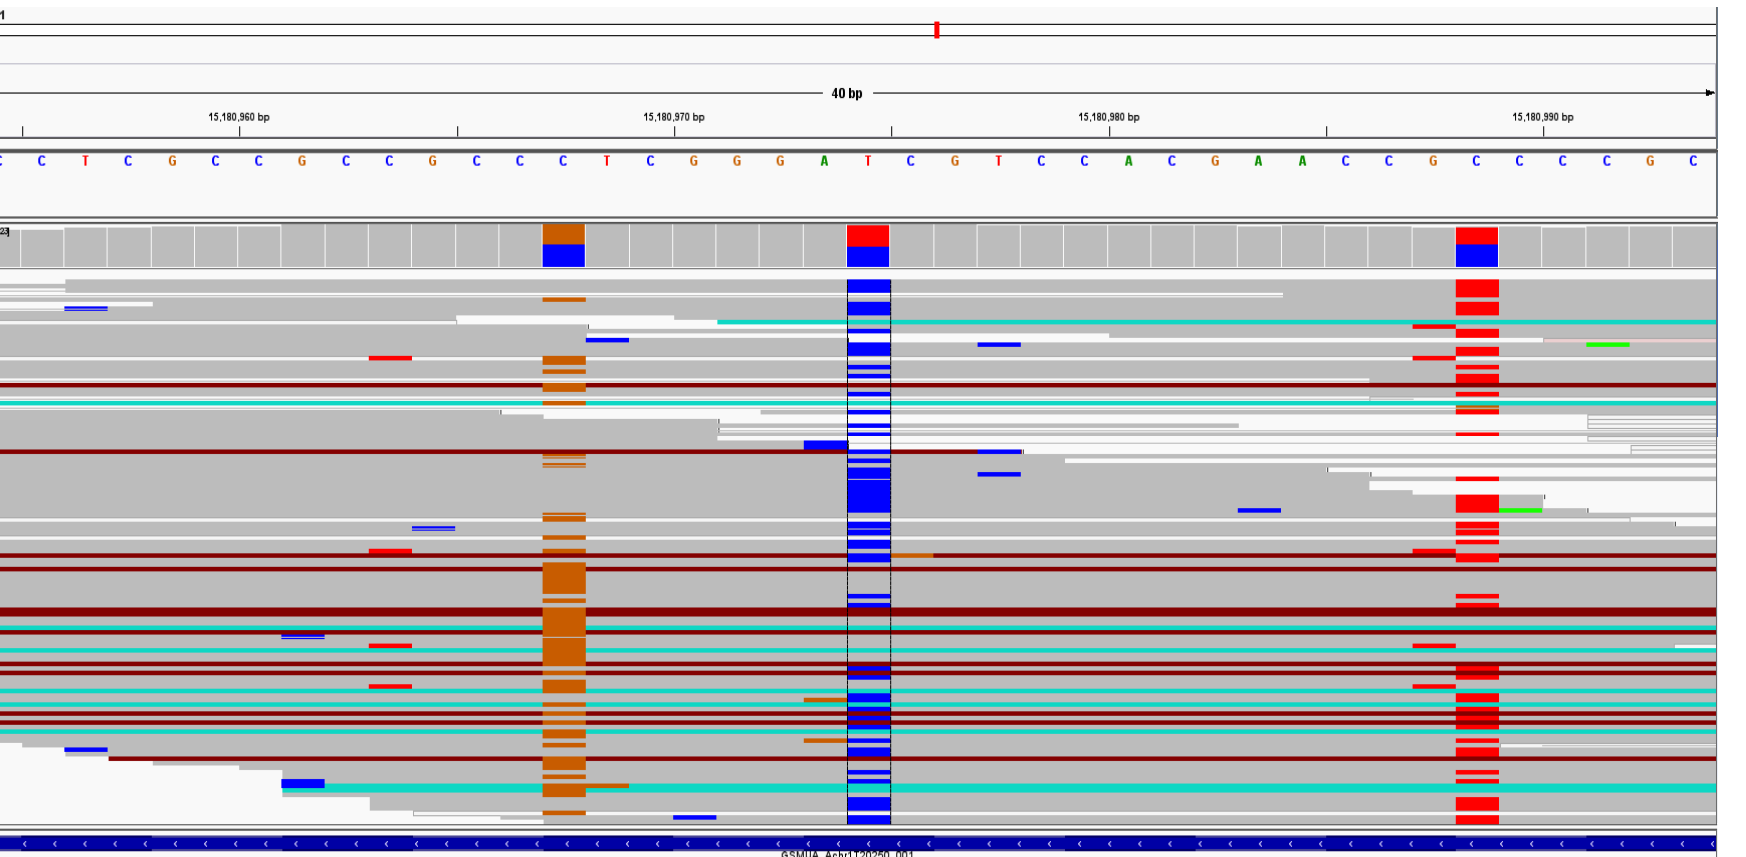
Figure 3. Example of a protein-coding gene that is heterozygous in enset. We aligned enset genomic sequence reads against the banana genome using BWA. The figure shows a 40-nucleotide region of the alignment falling within a protein-coding gene (GSMUA_Achr1T20250_001), encoding a predicted acyl-transferase. This region includes three single-nucleotide polymorphisms, at which the enset genome sequence is heterozygous with approximately 50:50 frequencies for two haplotypes (C…C…T and